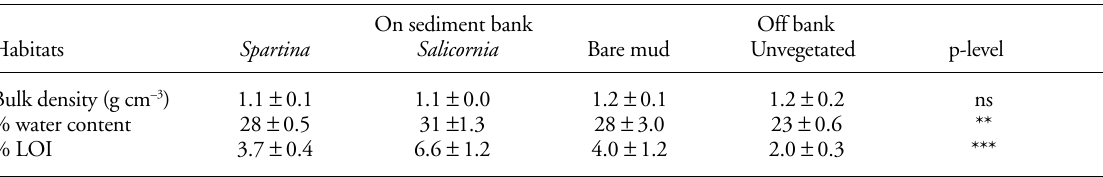
Table 2. Mean values and standard errors of bulk density, % water content and % LOI in each habitat and results of a 1-way ANOVA evaluating effect of habitat. (ns indicates not significant p>0.05, ** p<0.01, ***